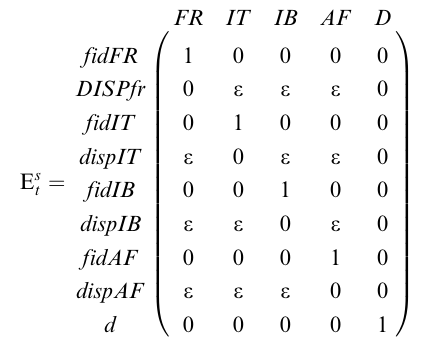
(Table 1; S AIC v , 0.16 for MLH and EBC).